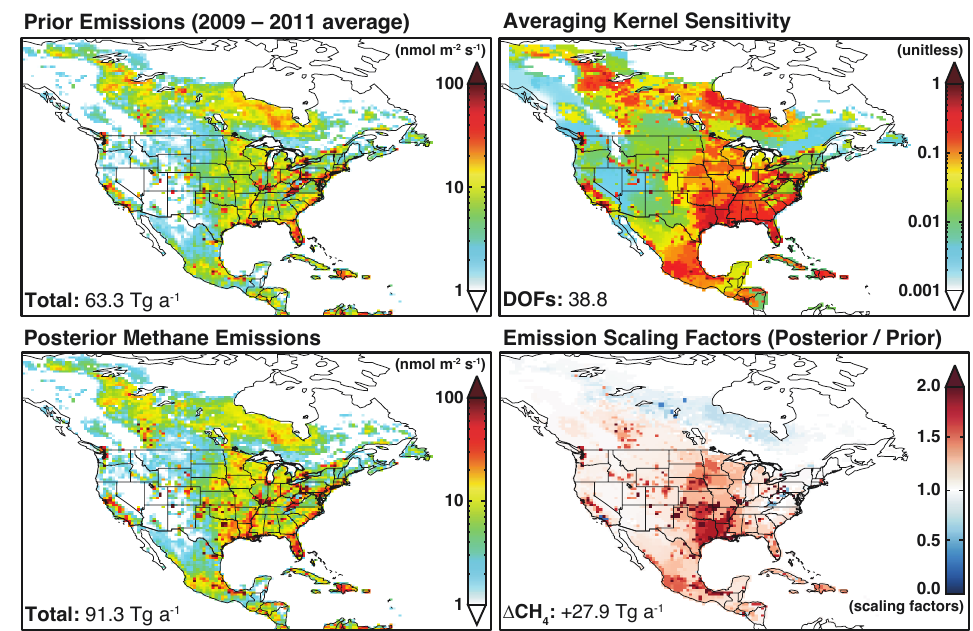
Figure 4. Methane emissions in North America in 2009–2011. The left panels show the prior and posterior emissions and the bottom right panel shows the scaling factors. The top right panel shows the diagonal elements of the averaging kernel matrix for the methane emission inversion. The degrees of freedom for signal (DOFS) is the trace of the averaging kernel